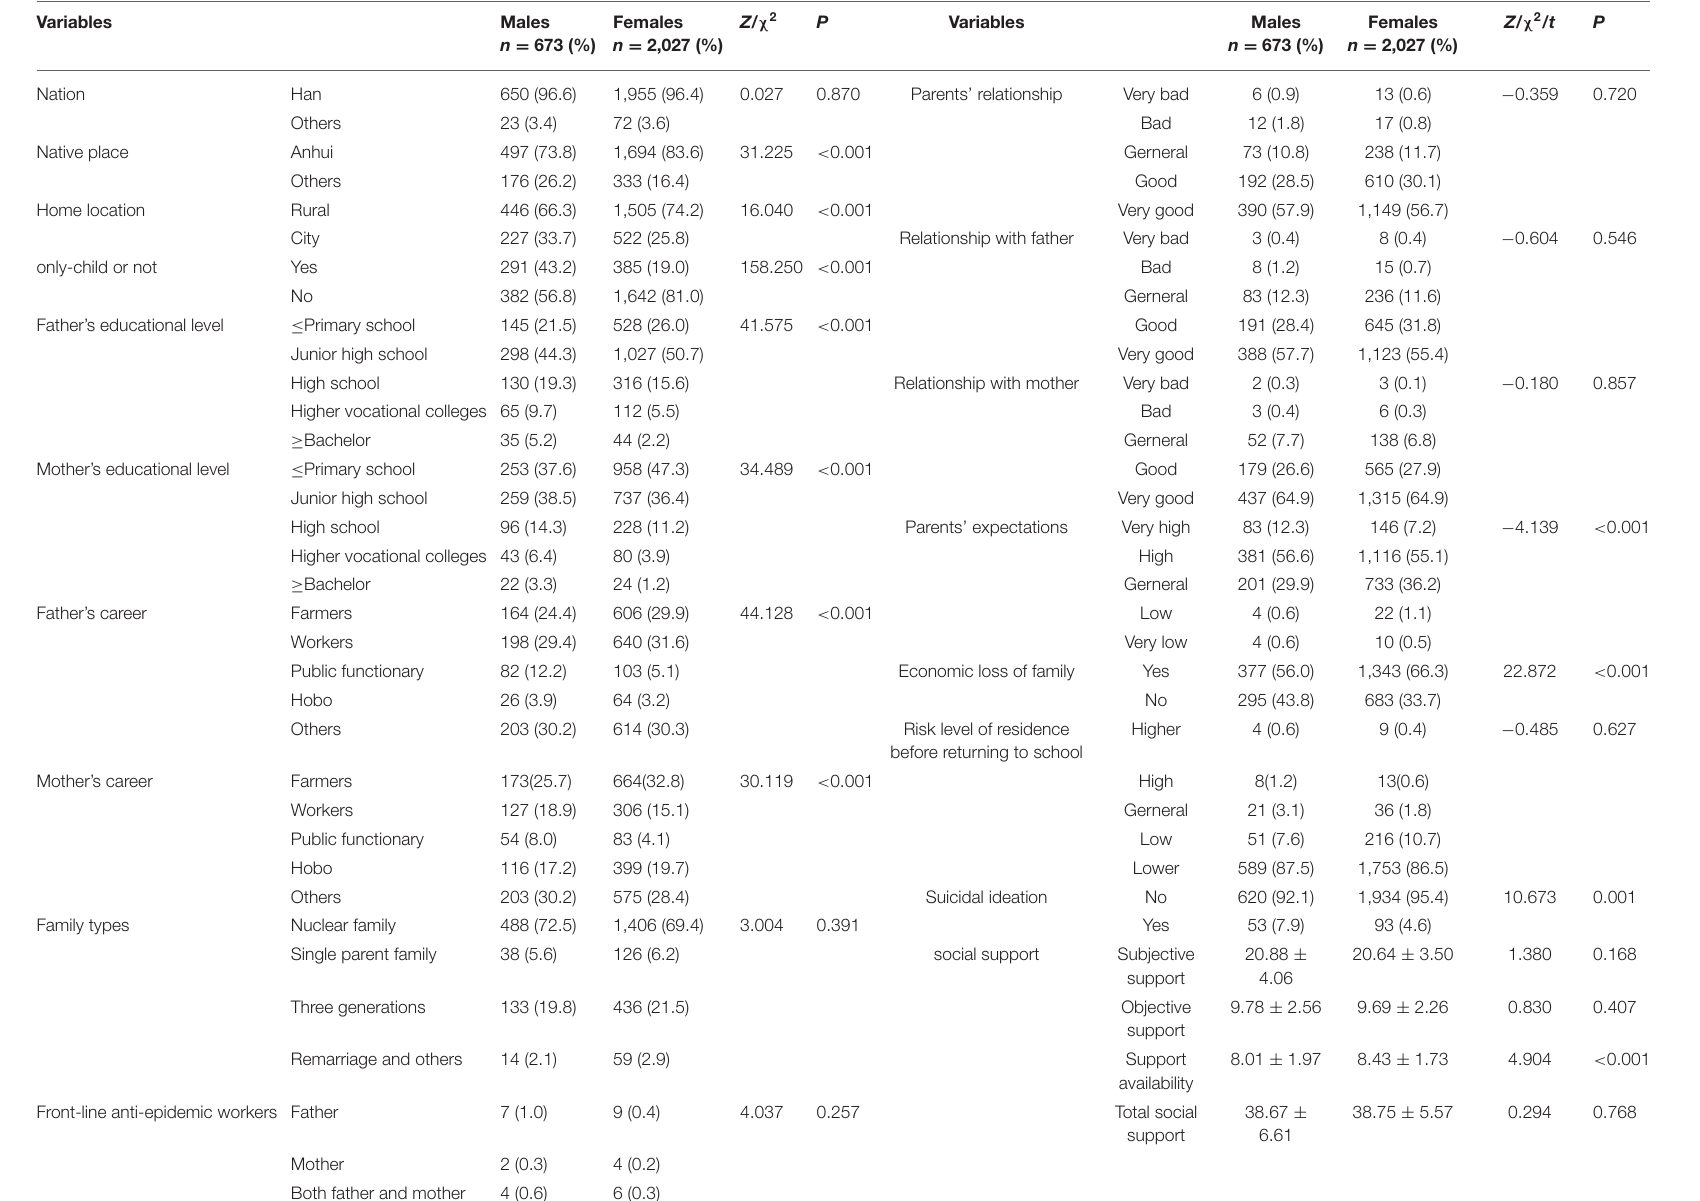
TABLE 1 | Comparison of family characteristics, social support and suicidal ideation between male and female students ( n = 2,700).